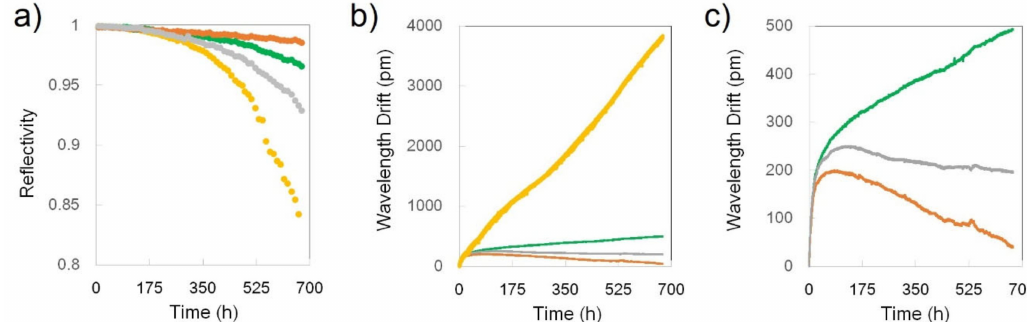
Figure 22. Changes to reflectivity and wavelength of 4 Type-a FBGs during annealing at 1000 ◦ C. ( a ) variation in reflectivity with annealing time, ( b ) wavelength drift of Bragg resonance, ( c ) zoom-in on the 3 slowly-drifting Type-a FBGs.